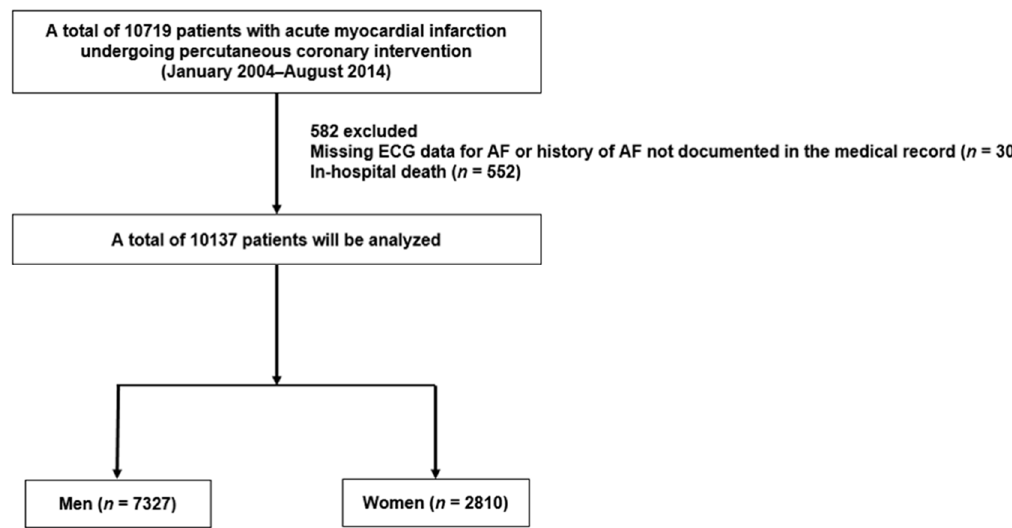
Figure 1. Study flow chart.